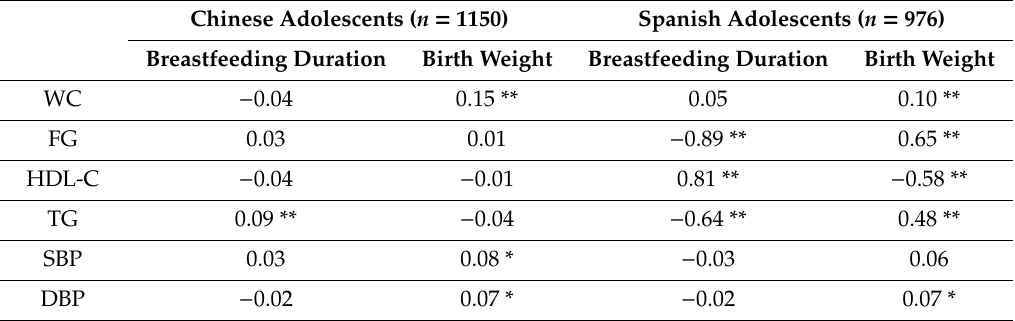
Table 3. The association of metabolic syndrome features and early-life factors in Chinese and Spanish adolescents. Chinese Adolescents ( n = 1150) Spanish Adolescents ( n = 976) Breastfeeding Duration Birth